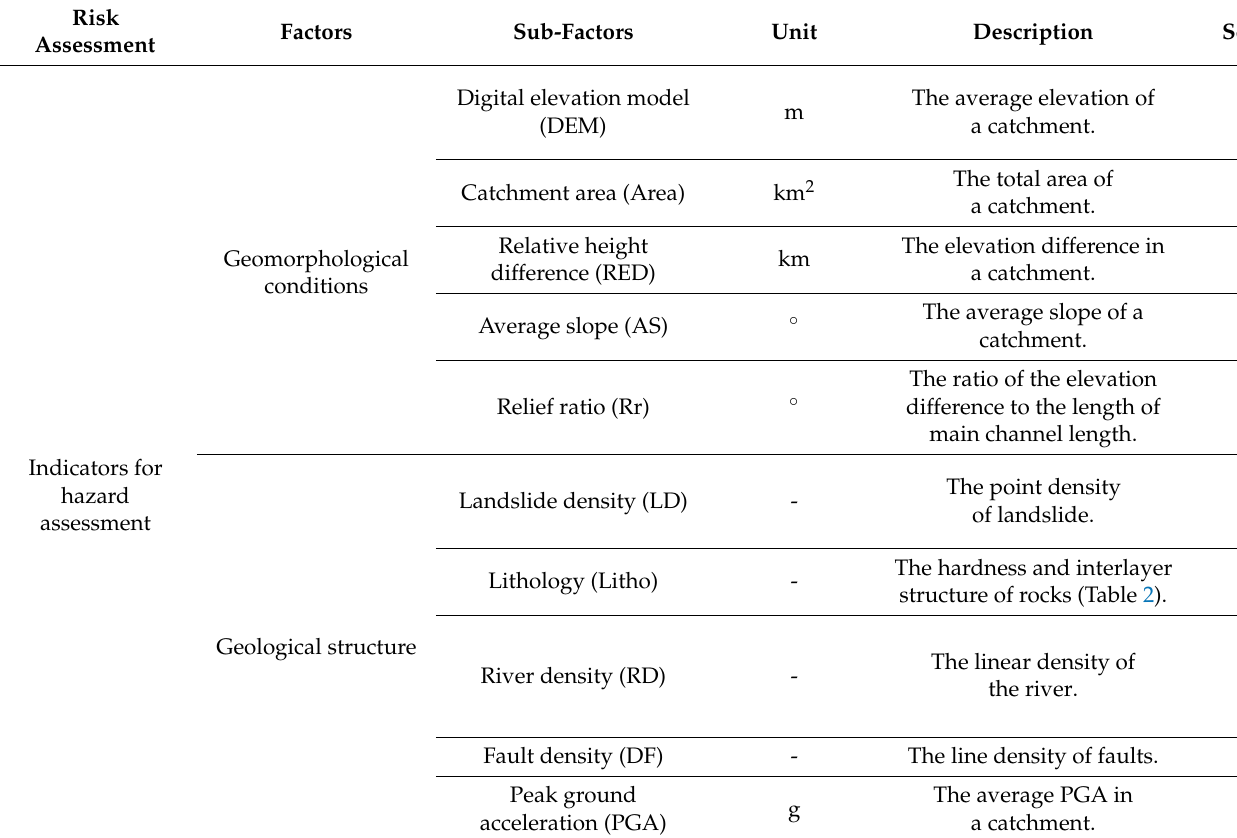
Table 1. Factors for risk